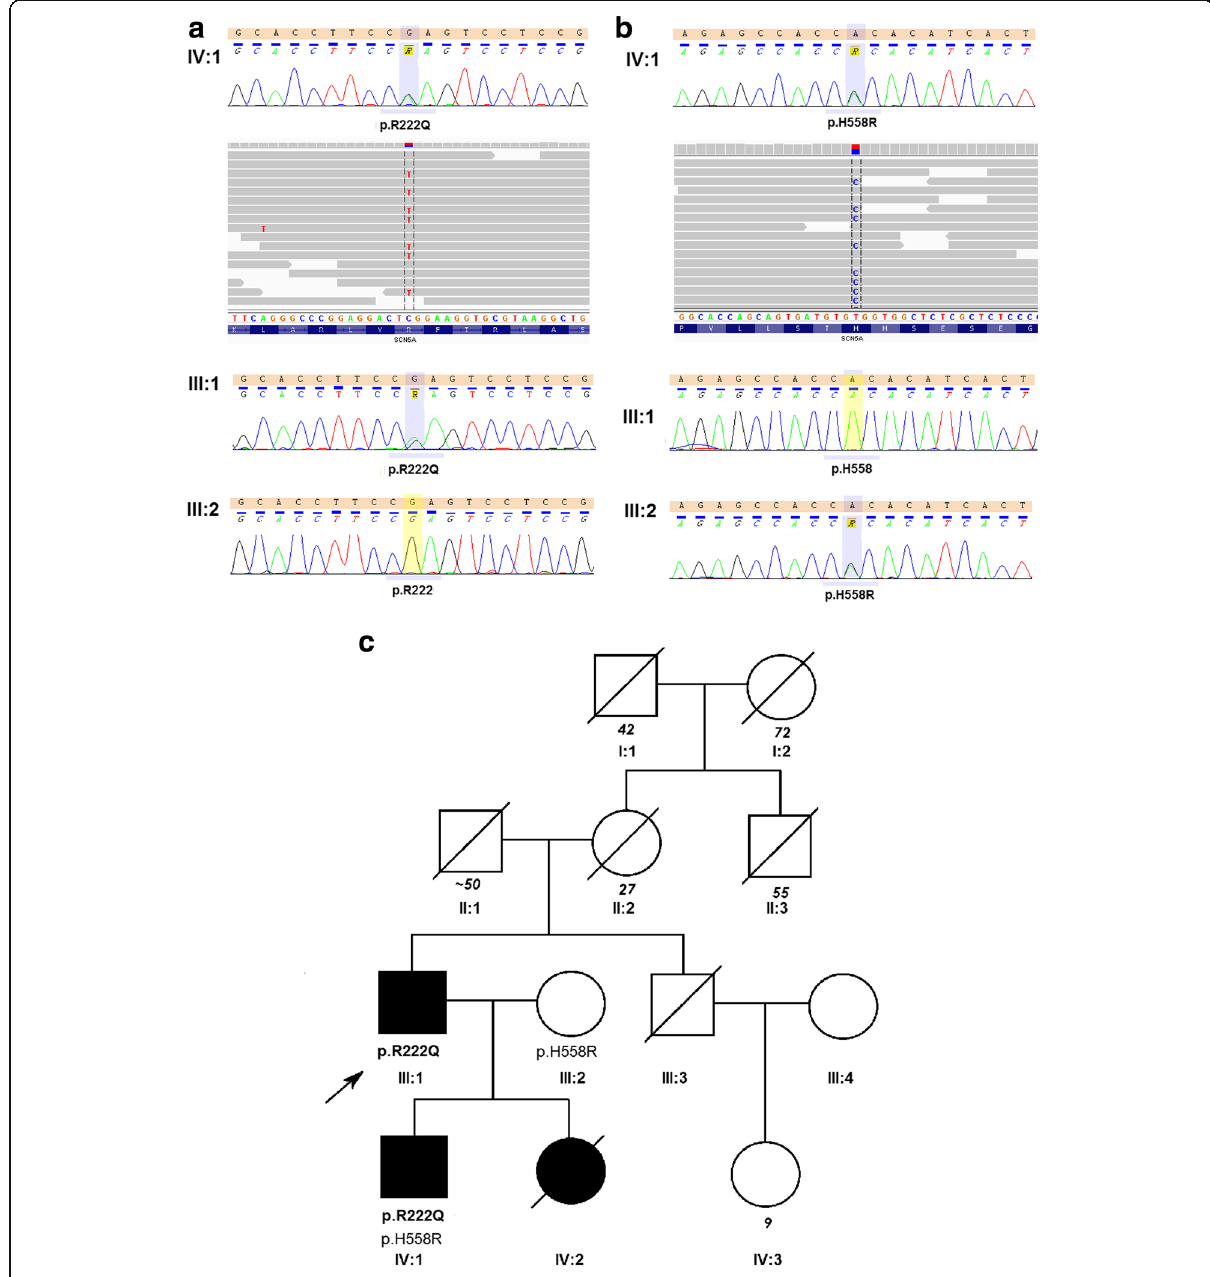
Fig. 1 Genetic characteristics of the studied family. Chromatograms and IGV views of SCN5A NM_198056.2:c.665G>A (p.R222Q) ( a ) and SCN5A NM_198056.2 :c.1673A>G (p.H558R) ( b ), variants and family pedigree ( c ). Pedigree: squares represent males and circles represent females. An arrowhead denotes the proband. A diagonal line marks the deceased individuals. Open symbols denote unaffected